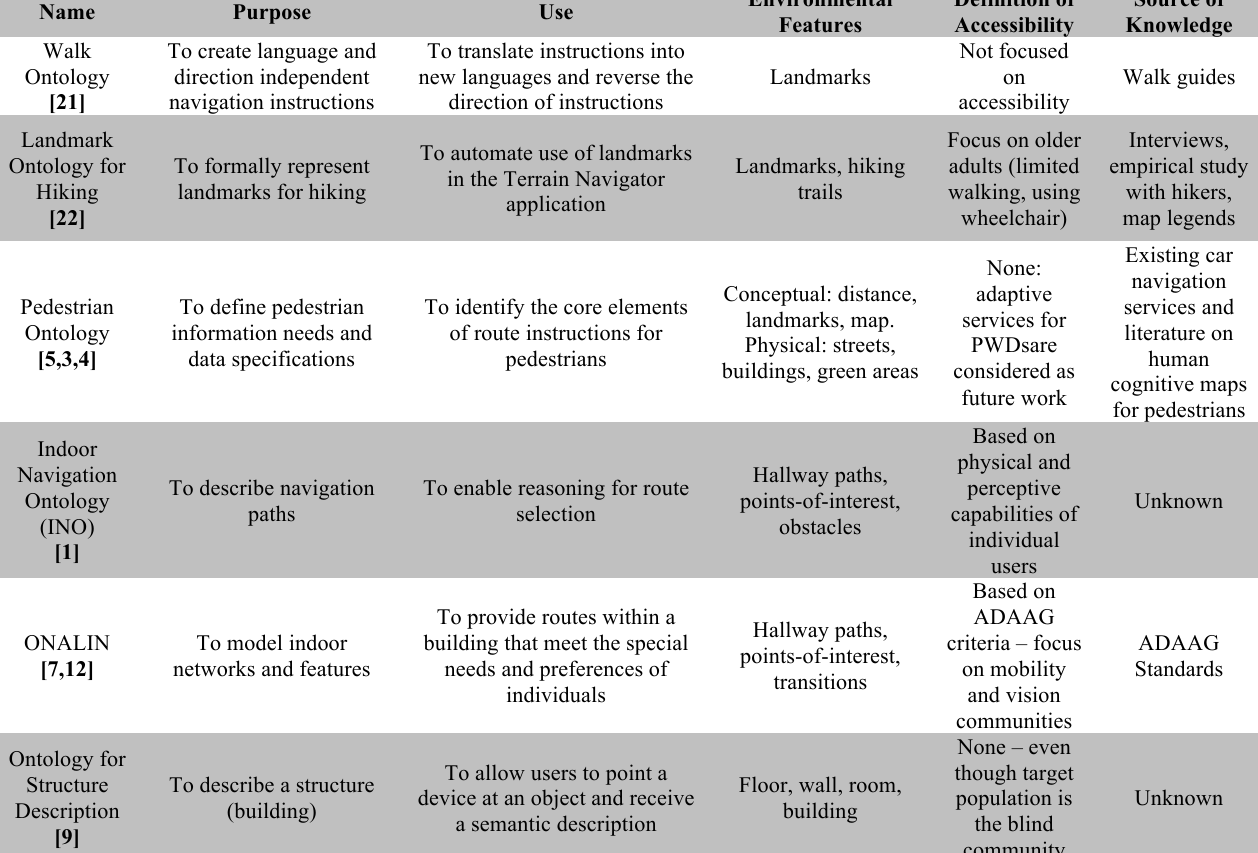
Table 2. Ontologies for pedestrian wayfinding and navigation